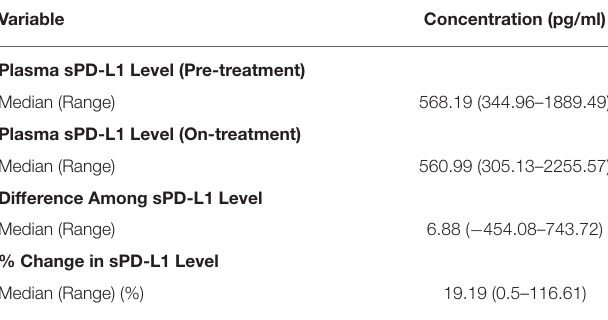
TABLE 1 | Distribution of plasma soluble PD-L1